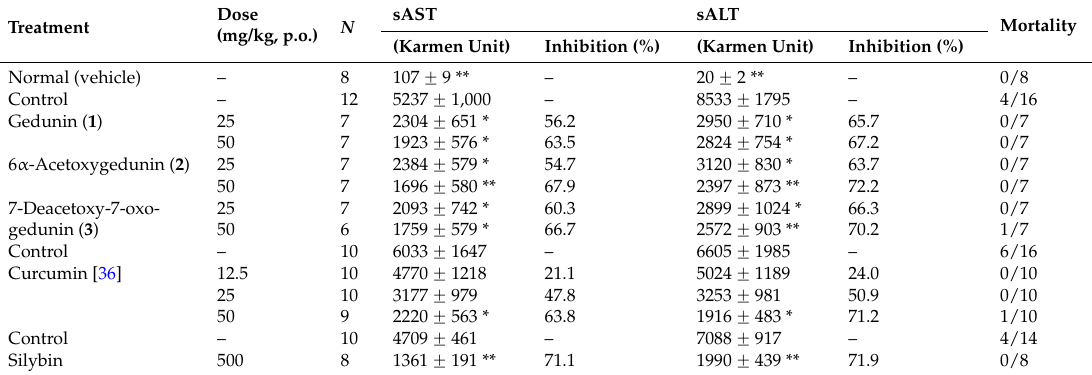
Table 1. Inhibitory effects of gedunin ( 1 ), 6 α -acetoxygedunin ( 2 ), and 7-deacetoxy-7-oxogedunin ( 3 ) on D -GalN/LPS-induced liver injury in mice. Dose sAST sALT Treatment (mg/kg, p.o.) N Normal